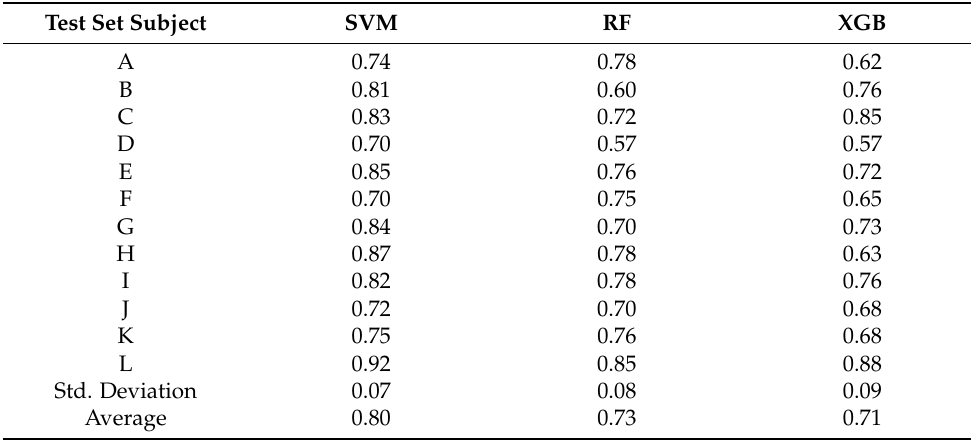
Table 7. Classification results for each test subject for the top three classifiers.